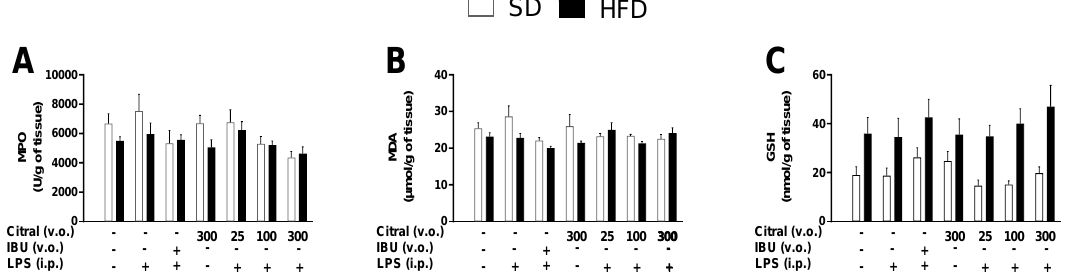
Figure 3. Effects of citral on local inflammation and oxidative stress on the gastric mucosa of animals fed standard diet (SD) and high-fat diet (HFD) after 360 min of the LPS-injection. We determined the MPO activity ( A ), as well as MDA ( B ) and GSH ( C ) levels, in eutrophic and obese mice. The results are presented as mean ± SEM for n = 7–9 per group. One-way ANOVA followed by Dunnett’s test. Two-way ANOVA followed by Bonferroni’s test.